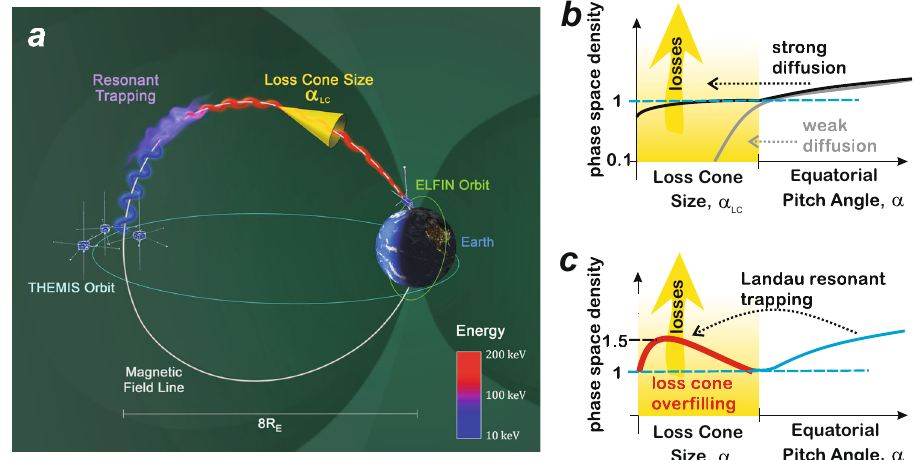
Fig. 1 Comparison of electron pitch-angle transport caused by wave-driven Landau resonant trapping to transport caused by diffusion. a Observed precipitation caused by Landau resonant interaction with whistler-mode waves. The initial electron (of approximately 10 keV) has a pitch angle α outside the loss cone, corresponding to a large radius of gyration (blue) around the magnetic fi eld line (white curve). But after resonant trapping and acceleration (to 60 – 150 keV) by whistler-mode waves (purple) observed at Time History of Events and Macroscale Interactions during Substorms (THEMIS) spacecraft on a near-equatorial orbit (cyan curve), the electron ’ s pitch angle enters the loss cone (yellow) and it is precipitated (red) toward the atmosphere, as observed by Electron Losses and Fields Investigation (ELFIN) spacecraft on a low-altitude polar orbit (green curve). b Normalized electron phase space density pro fi les (solid curves) from within the loss cone (yellow range, of maximum pitch angle α LC ) to outside it, for weak (grey) and strong (black) diffusion by waves. The electron phase space density within the loss cone remains much smaller than (for weak diffusion) or at most equal to (for strong diffusion) the phase space density of trapped electrons immediately outside the loss cone. c Same as ( b ) but for Landau resonant nonlinear trapping by intense oblique waves, leading to loss cone over fi lling (red) with higher electron phase space density (solid curve) within the loss cone than immediately outside it, and faster electron losses than for strong